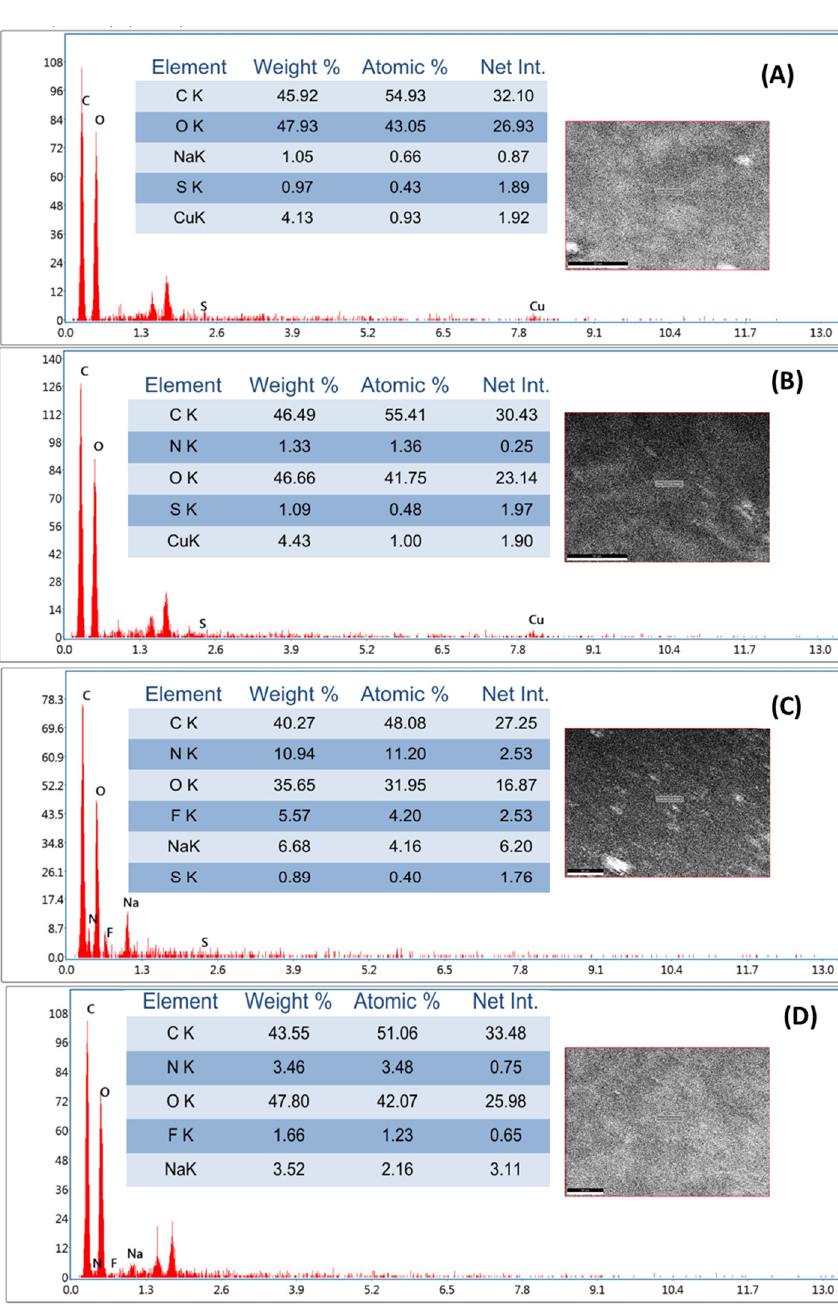
Figure 4. EDAX patterns of PSAAM-5FU ( A ), PSASB-5FU ( B ), PSAAM-Cu(II) ( C ) and PSASB-Cu(II) ( D ).